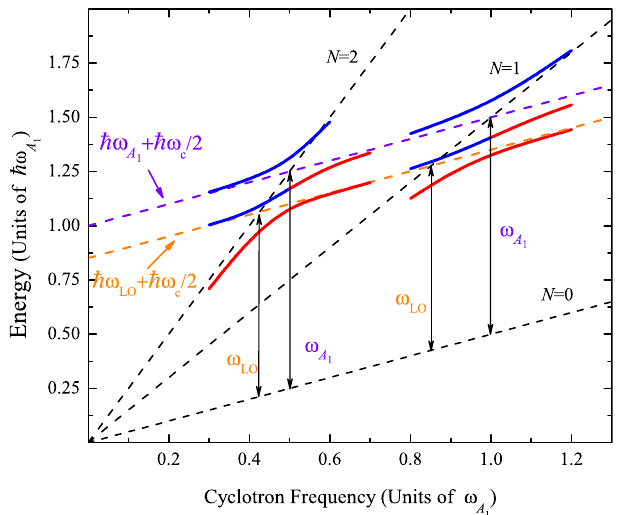
Figure 1. Scheme of the electronic excitations in ML TMD as a function of the cyclotron frequency, ω c , in the range of B where the energies are in resonance with the ω LO and ω A 1 phonons due to the EPI. Blue (red) solid lines represent the lower and upper branches above (below) the threshold ω LO and ω A 1 . The evolution and the interplay between the PF and A 1 -DP contributions to the two resonant anticrossing magneto-energies are shown as a function of B (see text for details). Black dashed lines indicate the bare Landau levels (cid:31) ω c ( N + 1 / 2 ) for N = 0 to 2 and the orange (violet) dashed lines correspond to the bare excited states (cid:31) ω LO + (cid:31) ω c / 2 ( (cid:31) ω A 1 + (cid:31) ω c / 2